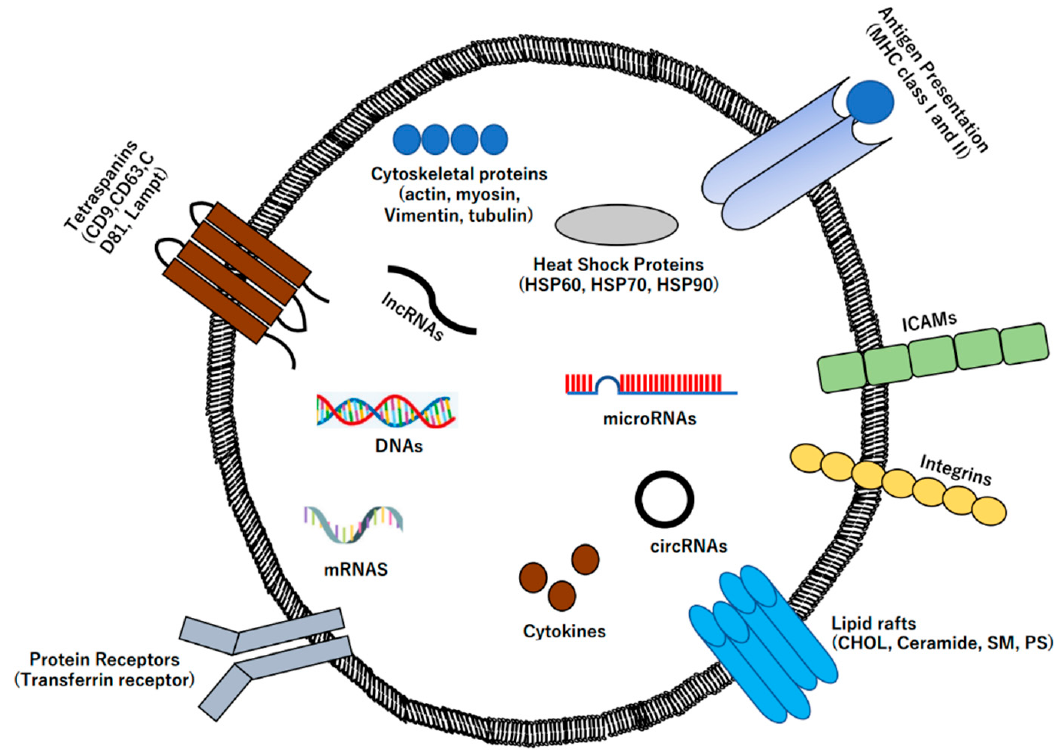
Figure 1. Extracellular vesicle structure. Exosome consists of lipid bilayer membrane, including proteins such as cytoskeletal proteins (actin, myosin, vimentin, tubulin, etc.), heat shock proteins (HSP60, HSP70, HSP90, etc.), tetraspanins (CD9, CD63, CD81, etc.), cytokines (IL-1 β , TNF- α , IL-6, etc.), Lamp, nucleic acids such as microRNAs, circRNAs, IncRNAs, lipid rafts such as cholesterol, ceramide, sphingomyelin, phosphatidylserine, and protein receptor such as transferrin receptor.